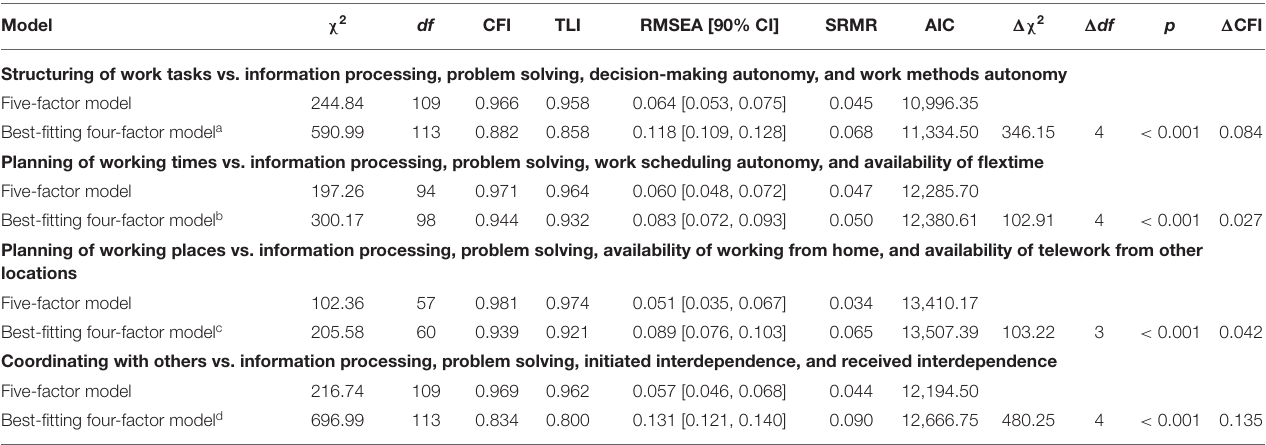
TABLE 4 | Fit indices of models to test whether each subscale measures a construct that is different from other similar constructs. Model χ